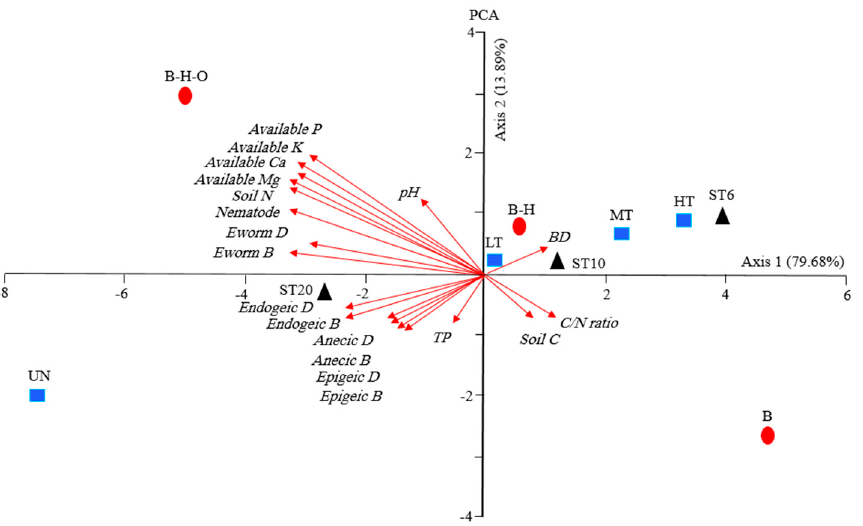
Figure 5. PCA analysis of the measured variables (soil physicochemical and biological